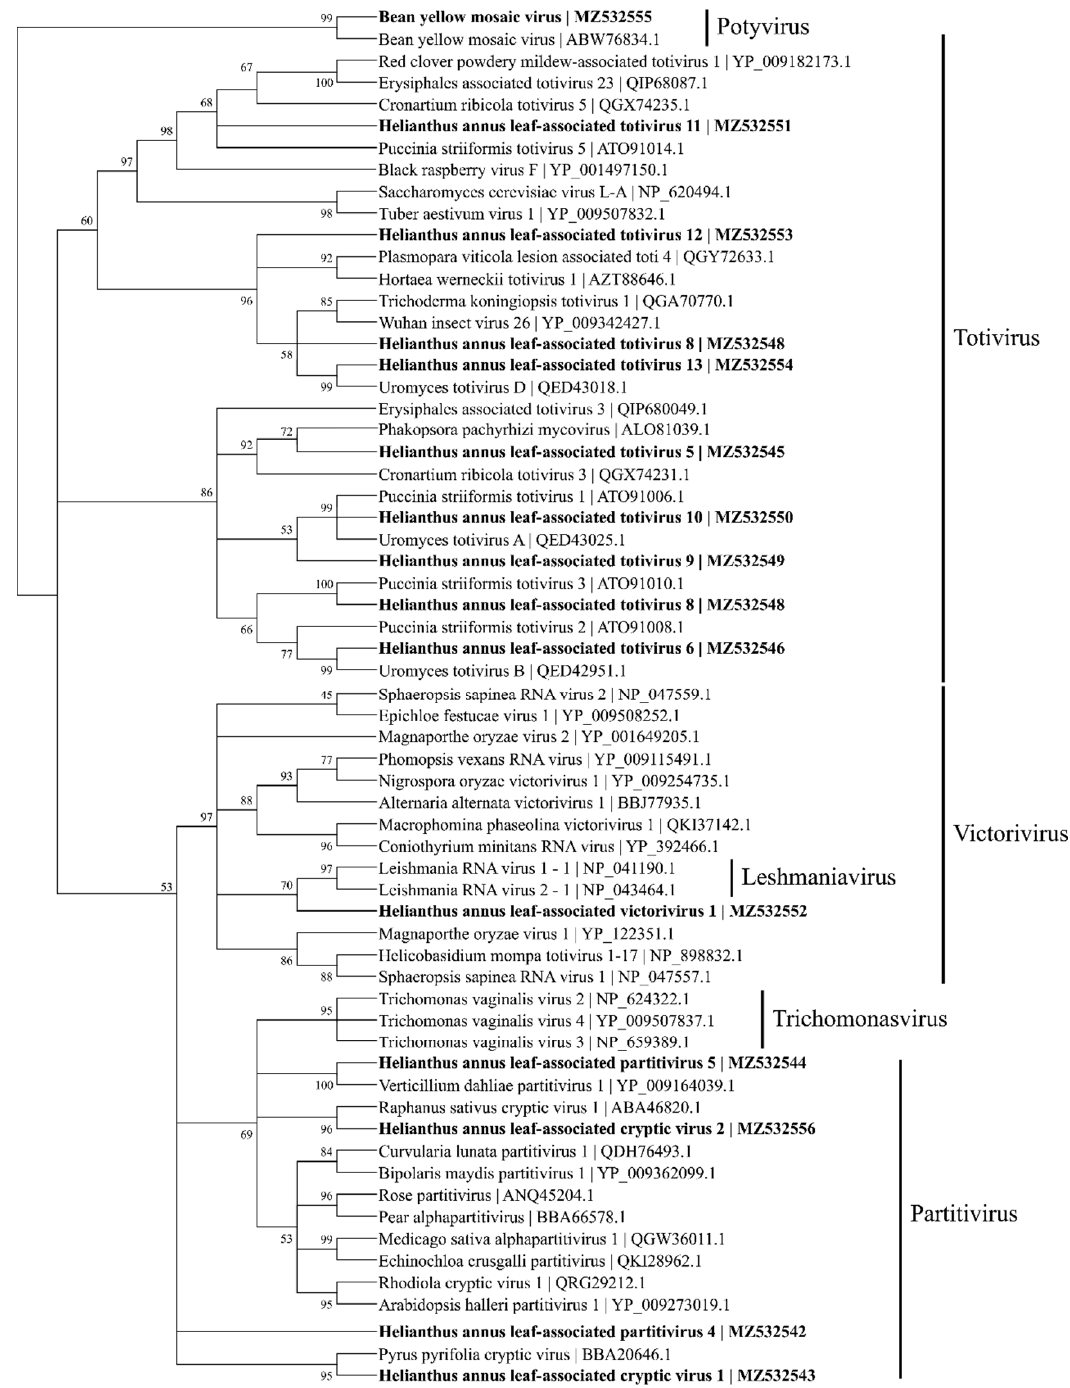
Figure 5. Phylogenetic tree based on maximum likelihood depicting the relationships of the predicted amino acid sequences of coat proteins for 14 viral contigs belonging to Totiviridae and Parititiviridae using a detected bean yellow mosaic virus as the outgroup. A total of 1000 bootstrap replicates were analyzed.